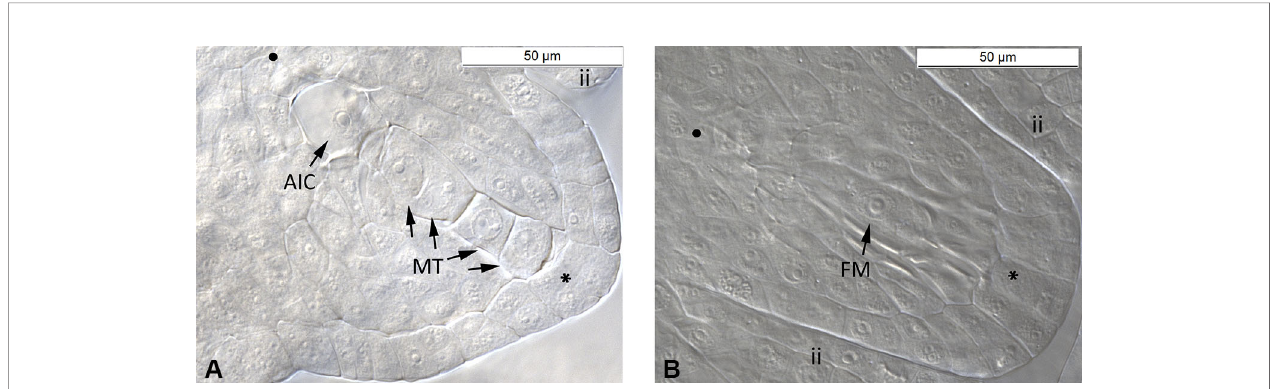
FIGURE 1 | Megasporogenesis of R. variabilis plants. (A) Asexual ovule during megaspore formation. The germline with megasporocyte tetrad and one aposporous initial cell near the chalazal pole is shown. (B) Sexual ovule during functional megaspore formation. Only one cell near the chalazal pole survived and developed into a functional megaspore whereas the other three cells are aborted. Plant individual: (A) LH1406030B4-7 (Tetraploid); (B) LH1406030B4-19 (Tetraploid). AIC, Aposporous Initial Cell; FM, Functional Megaspore; ii, inner integument; MT, Megaspore Tetrad; SY, Synergid; (cid:129) , chalazal pole; *, micropylar pole. Scale bar: 50